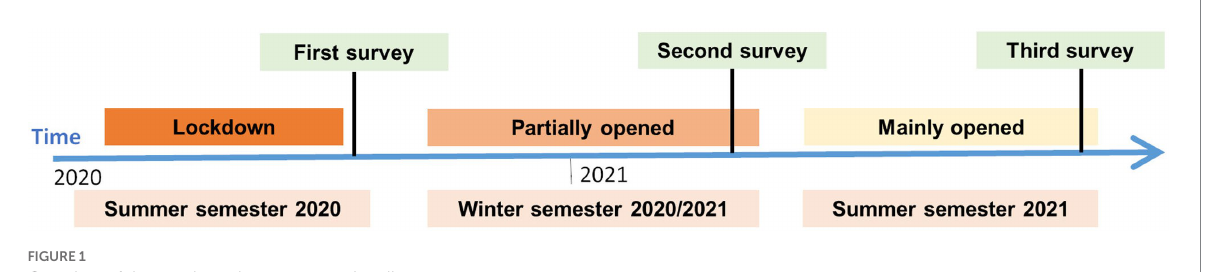
FIGURE 1 Overview of the conducted surveys on a time